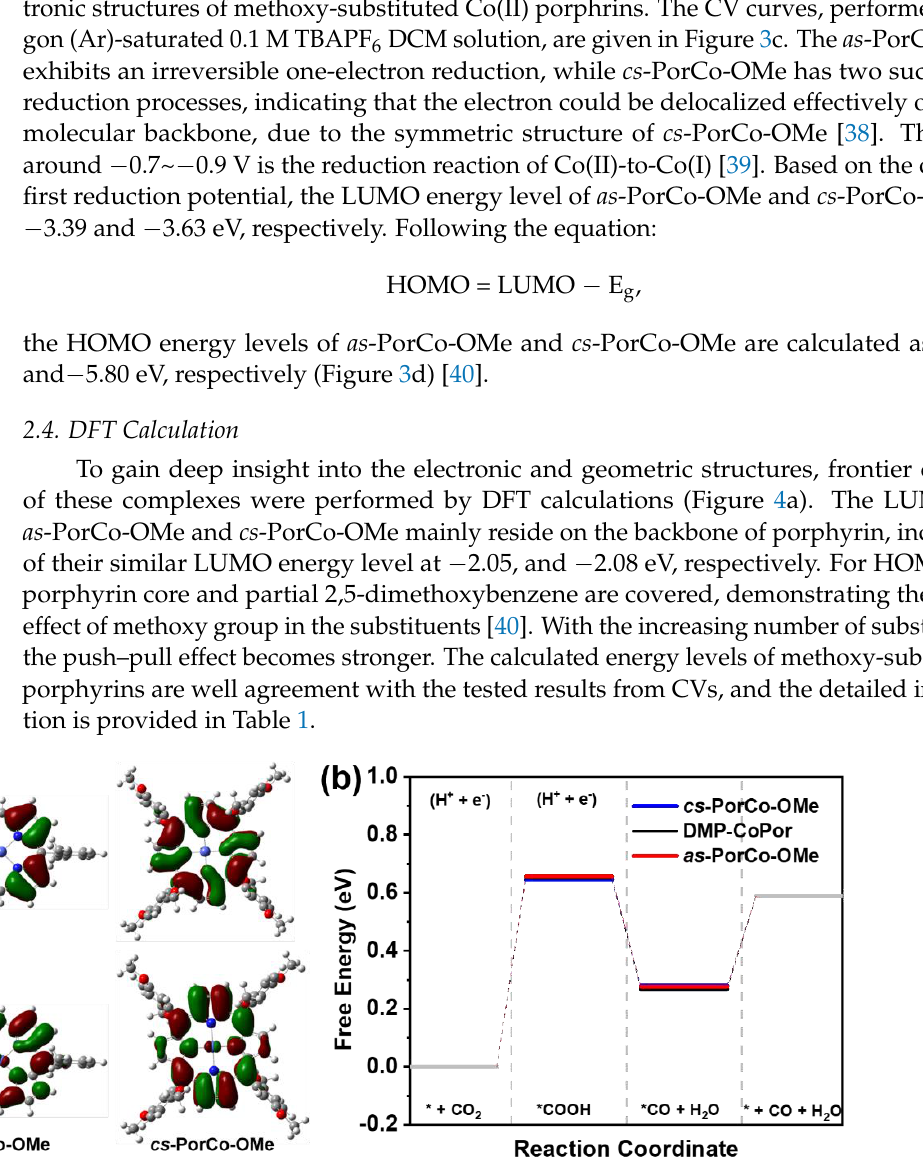
Figure 4. ( a ) Calculated HOMO and LUMO levels of of as -PorCo-OMe and cs -PorCo-OMe; ( b ) Free energy of as -PorCo-OMe and cs -PorCo-OMe in different CO 2 RR steps. energy of as -PorCo-OMe and cs -PorCo-OMe in different CO 2 RR steps. Table 1. Electrochemical data of as -PorCo-OMe and cs Table 1. Electrochemical data of as -PorCo-OMe and cs -PorCo-OMe.